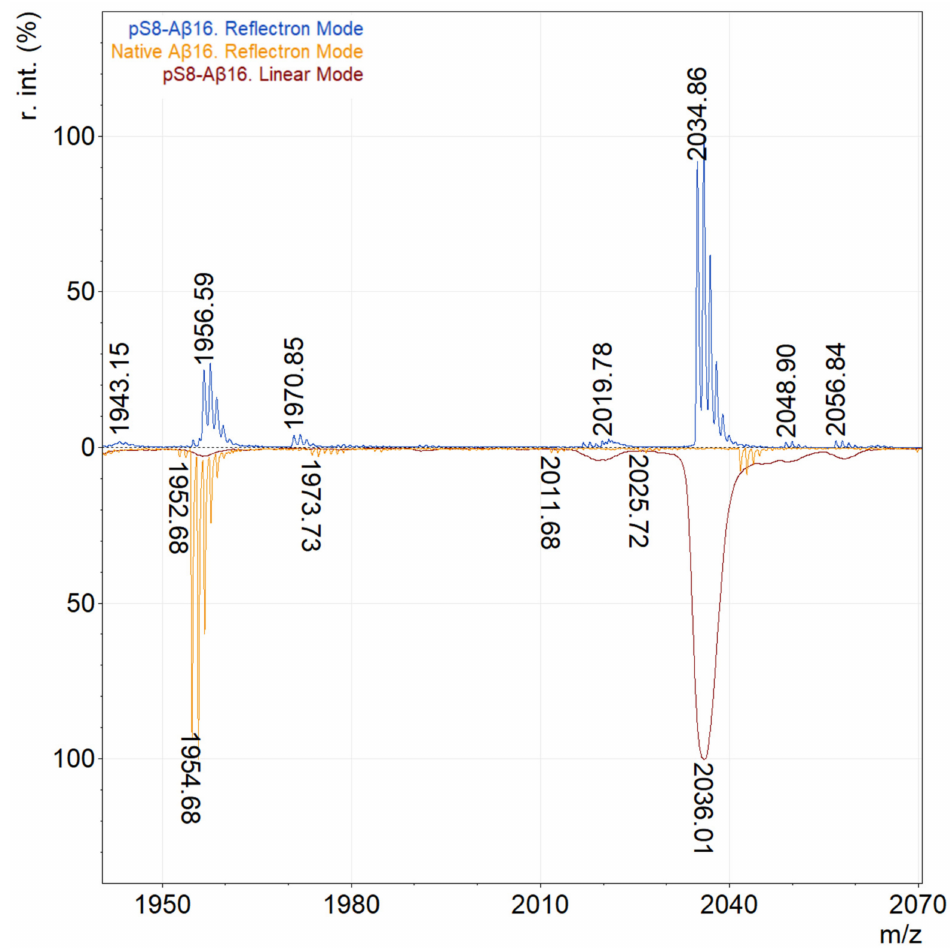
Figure 1. Comparison of mass spectra of pSer8-A β (1–16) in linear and reflectron modes. The blue line shows the mass spectrum of pSer8-A β (1–16) in reflectron mode, orange—A β (1–16) in reflectron mode, and red—pSer8-A β (1–16) in linear